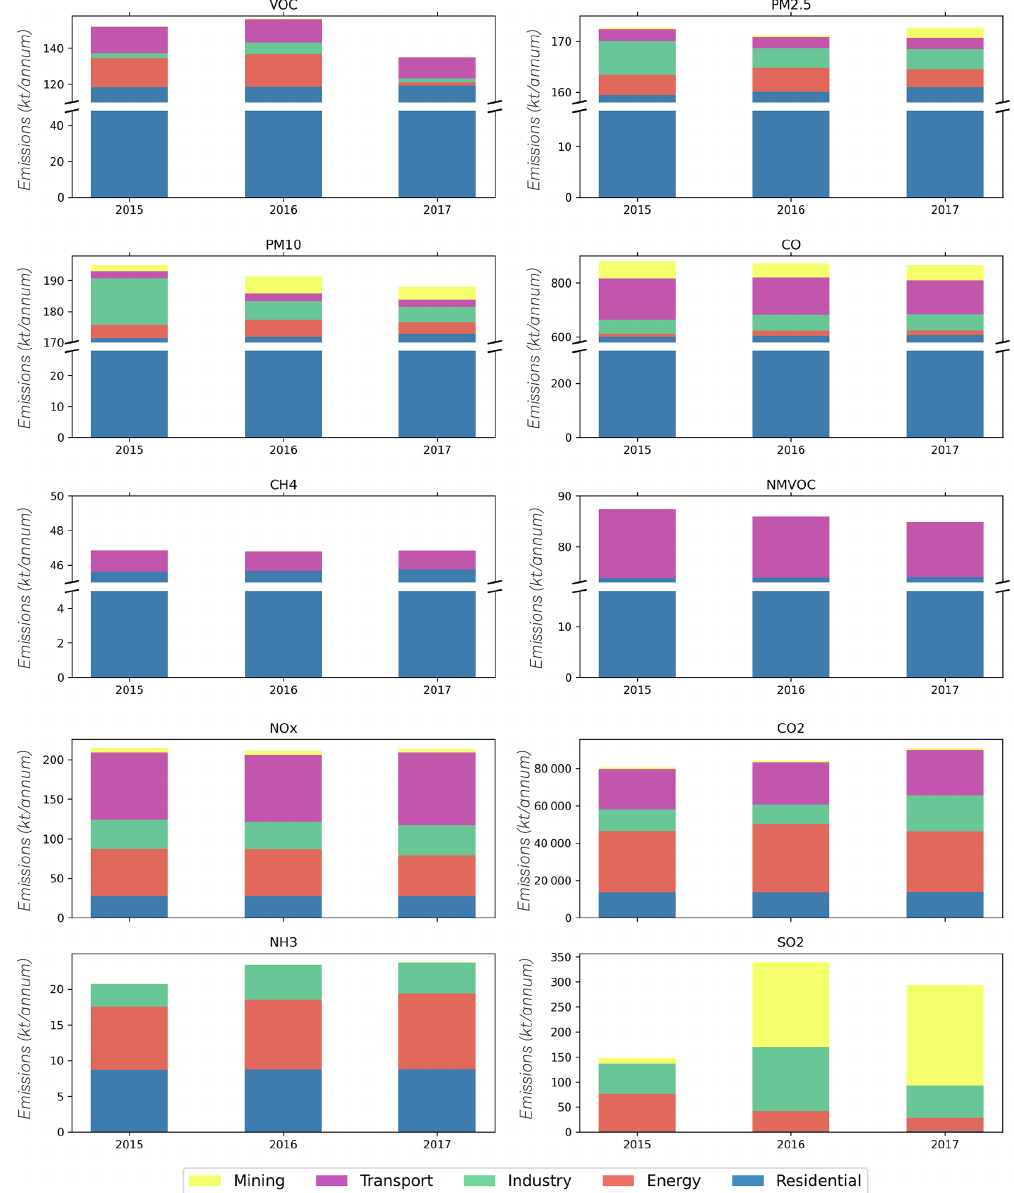
Figure 4. Total national annual emissions distributed by sector for pollutants VOC, PM 2 . 5 , PM 10 , NO x , NH 3 , CO 2 , CO and SO 2 in kilotons for